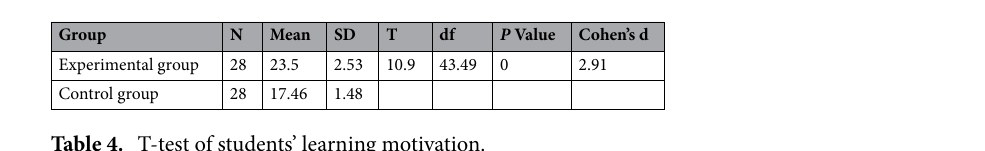
Table 4. T-test of students’ learning